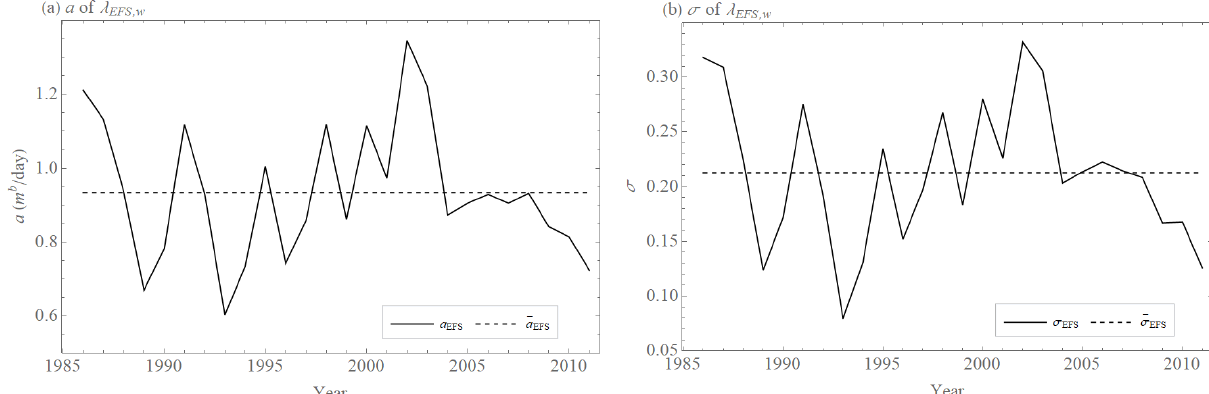
Figure 6. Values of coefficients a (a) and exponents σ (b) of the extended power law λ w (E) (Eq. 26) approximated from annual averages of the error growth rate λ EFS (E) of the ECMWF forecasting system’s 500hPa geopotential height values (Northern Hemisphere, 20–90 ◦ ) calculated as differences between two operational forecasts issued with 1d lag but valid on the same day (black) and the average value of